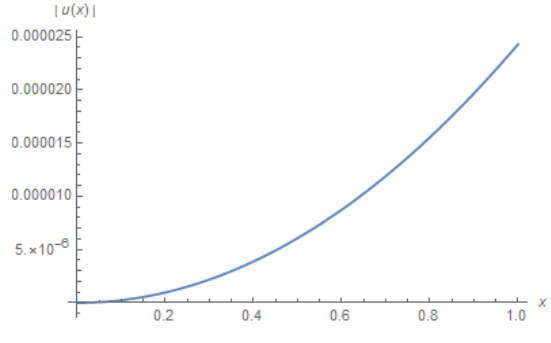
Figure 3:3D Solutions of example2 with di⁄erent values of (cid:11)